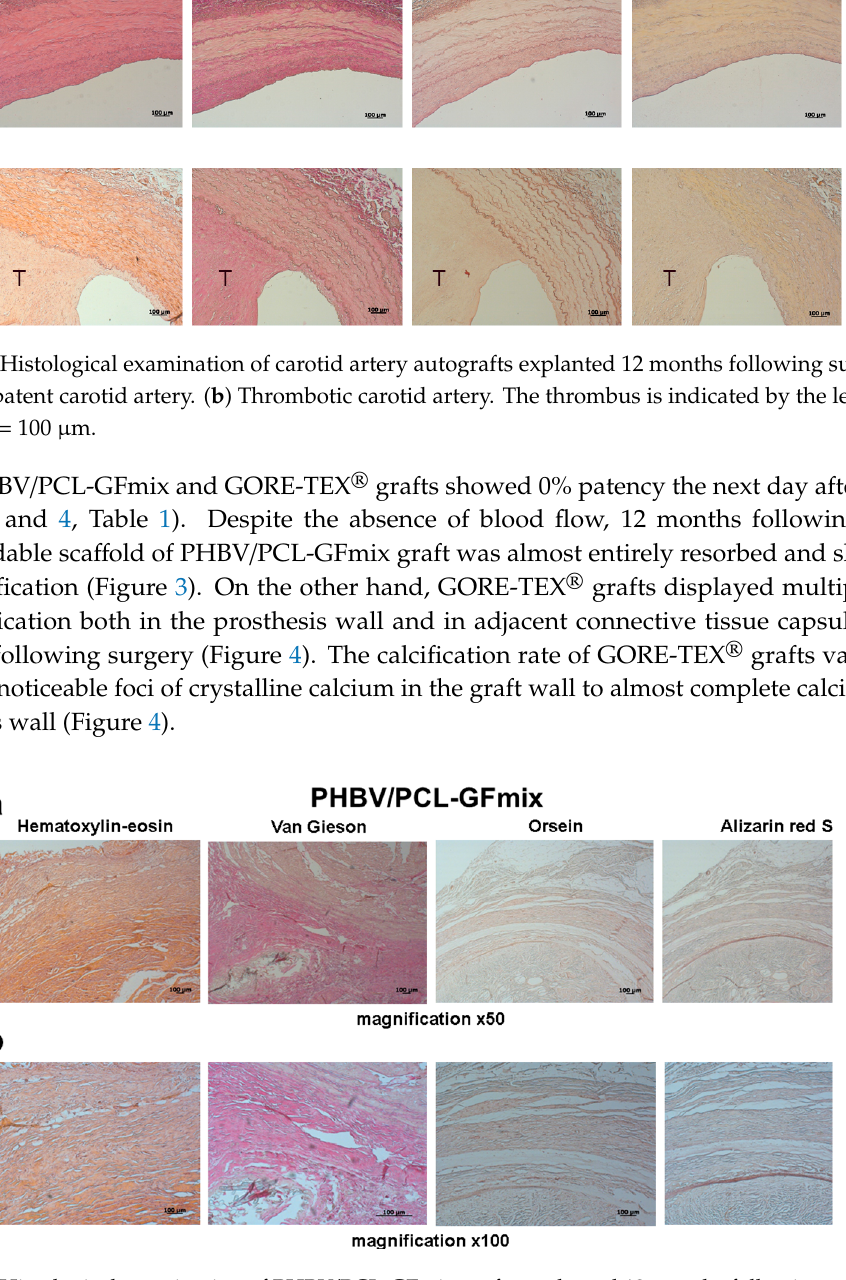
Figure 3. Histological examination of PHBV/PCL-GFmix grafts explanted 12 months following surgery. ( a ) Magnification ×50. ( b ) Magnification ×100. Scale bar = 100 μ m. PHBV/PCL-GFmix Hep/Ilo grafts were patent in 62.5% animals 9 months following implantation,